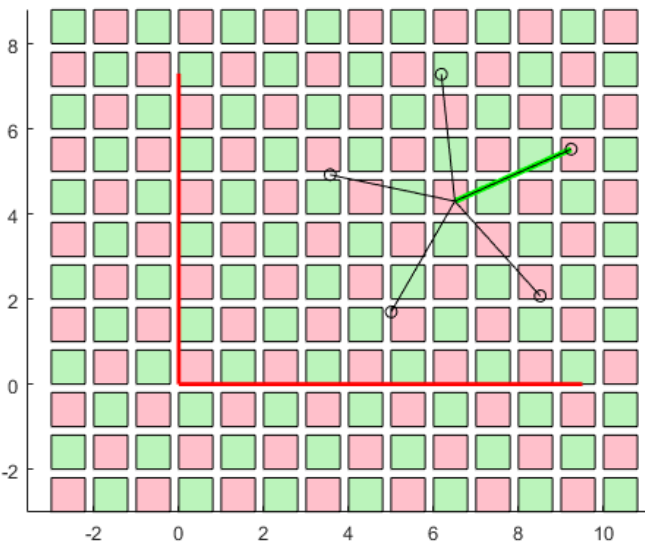
Figure 4. Example of robot pose with respect to the powered floor. The red lines are the axes of the inertial reference frame, the green segment indicates the position of the first contact pin. Pink squares represent Z r pads, green squares represent Z c ones. The green segment